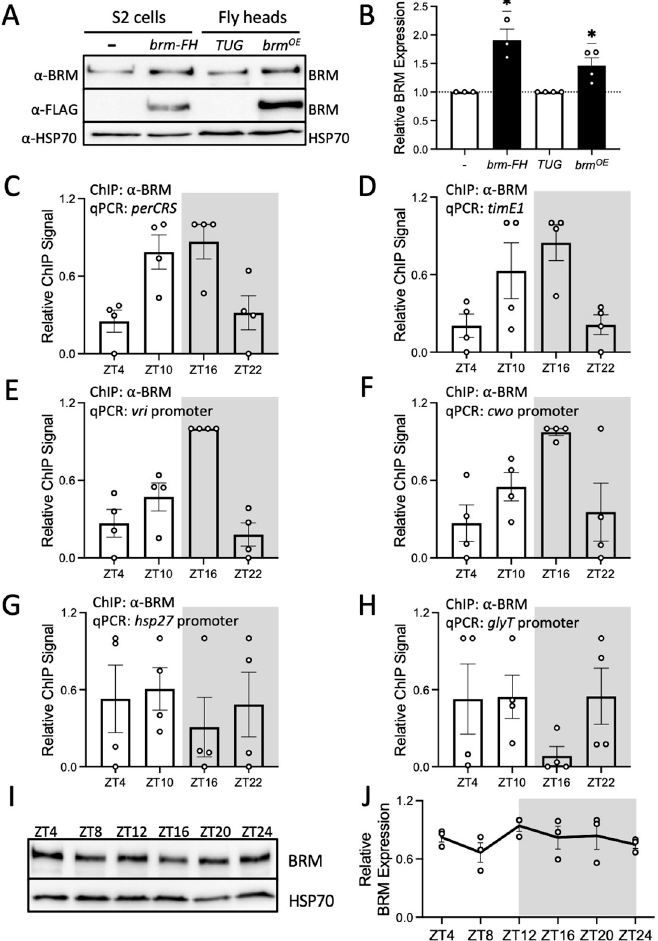
Fig 1. BRM binding to clock gene promoters in fly heads is rhythmic despite constitutive BRM protein expression. (A) Western blot validation of the BRM antibody detecting proteins extracted from Drosophila S2 cells and heads of flies collected at ZT16 on LD3 (light-dark cycle day 3) subsequent to 2-day entrainment at 12h:12h LD. S2 cells were either untransfected or transfected with pAc-brm-3XFLAG-His . The two fly lines used for validation are flies expressing either endogenous levels of BRM ( w; tim(UAS)-Gal4 parental driver line referred to as TUG ) or flies expressing FLAG-His-tagged BRM (referred to as brm OE ) (top panel). FLAG epitope was simultaneously detected to confirm expression of FLAG-tagged BRM (middle panel). HSP70 was used as a loading control (bottom panel). (B) Quantification of BRM signal shown in Fig 1A. Each data point represents a biological replicate. Error bars represent ± SEM (S2 cells: n = 3; Fly heads: n = 4). Asterisks denote significant p-values: � p < 0.05. (C-H) BRM occupancy at the promoters of (C) period ( per ), (D) timeless ( tim ), (E) vrille (vri) , (F) clockwork orange (cwo) , (G) heat shock protein 27 ( hsp27) , and (H) glycine transporter ( glyT ) was detected in heads of w 1118 (WT) flies collected at the indicated time points on LD3 subsequent to 2-day entrainment at 12h:12h LD. The grey background denotes the dark phase of the LD cycle. Each data point represents a biological replicate (n = 4), and each biological replicate is an average of 2 technical replicates of qPCR. RAIN: (C) p = 0.0053; peak: ZT16, (D) p = 0.0487; peak: ZT16, (E) p = 0.0124; peak: ZT16, (F) p = 0.0005; peak: ZT16, (G) p = 0.9543, and (H) p = 0.3140 (I) Western blot showing BRM expression in heads of w 1118 flies (top panel) collected at the indicated time points on LD3. HSP70 was used as a loading control (bottom panel). (J) Quantification of BRM signal normalized to HSP70 as shown in Fig 1I (n = 3, RAIN p = 0.5811). https://doi.org/10.1371/journal.pgen.1010649.g001 orange ( cwo ) (Fig 1C RAIN p = 0.0053; peak: ZT16, Fig 1D RAIN p = 0.0487; peak: ZT16, Fig 1E RAIN p = 0.0124; peak: ZT16, and Fig 1F RAIN p = 0.0005; peak: ZT16; ZT is defined as Zeitgeber Time, and ZT0 denotes lights on time in the LD cycle). To assess the specificity of rhythmic BRM occupancy, we also assessed BRM binding at the promoters of two non-clock